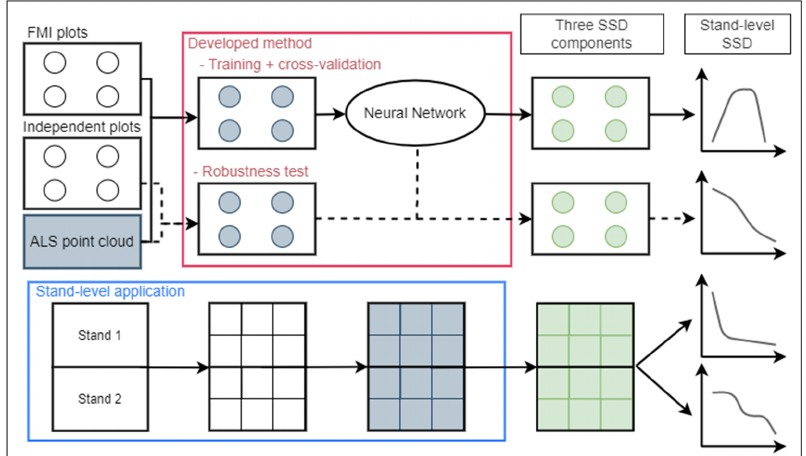
Figure 2. Overall approach. Solid arrows indicate successive steps while dashed arrows show robustness test steps. SSD, stem-size distribution; FMI, forest management inventory.